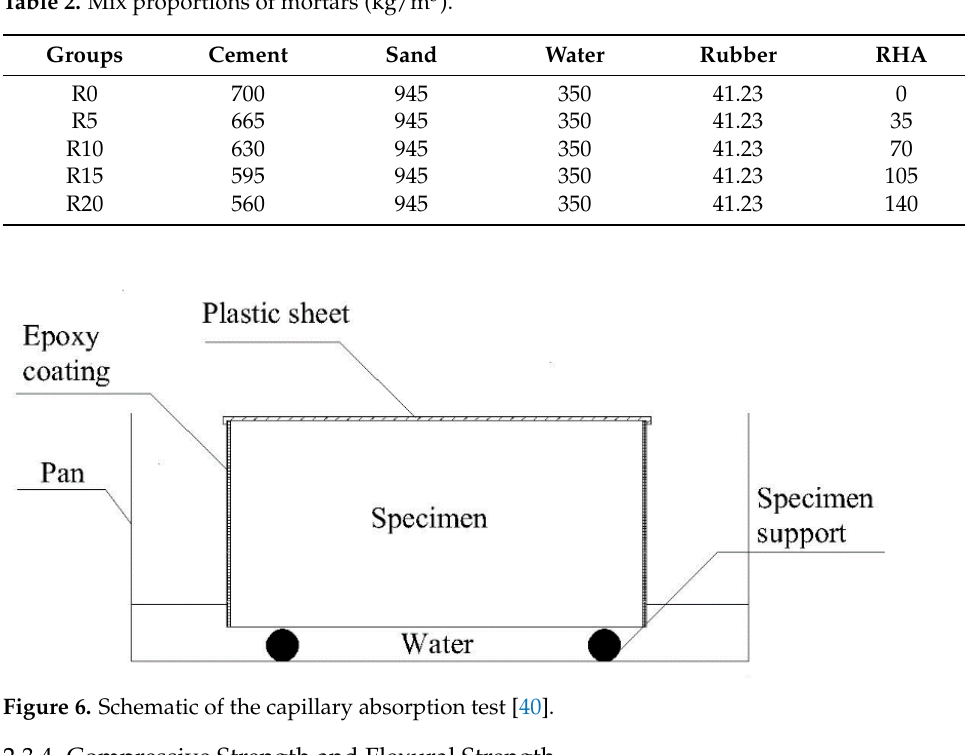
Figure 6. Schematic of the capillary absorption test [40].